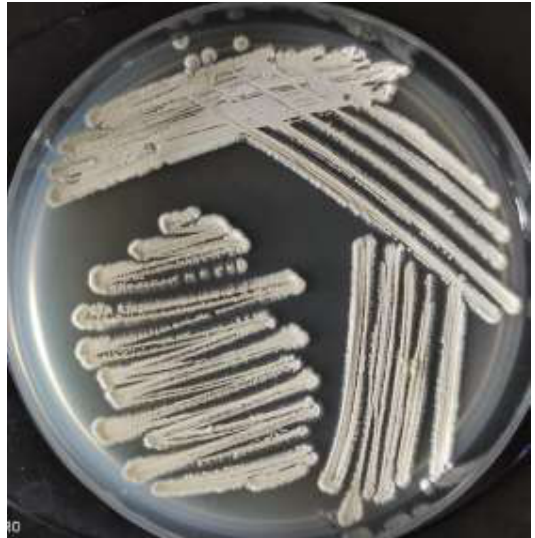
Figure 1. Streptomyces bacteria on starch casein agar.